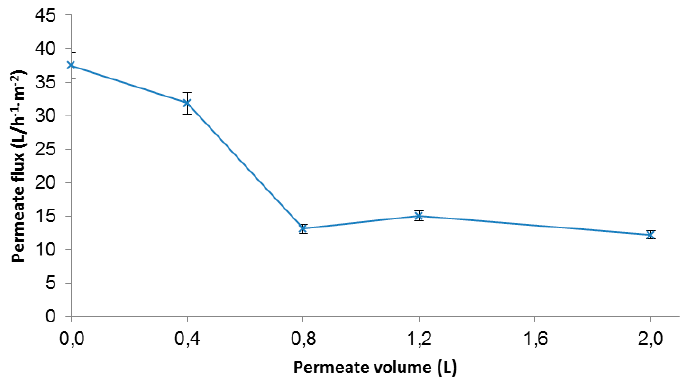
Figure 7. Effect of pH on CY dye removal by a nanofiltration membrane.